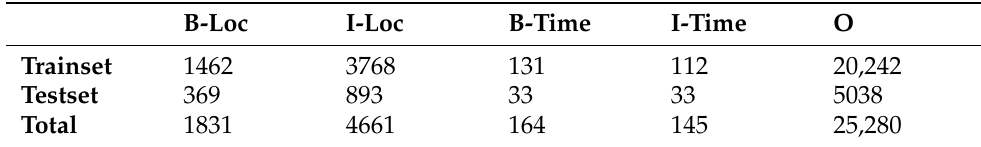
Table 6. Number of tokens per label and dataset. B-Loc I-Loc B-Time I-Time